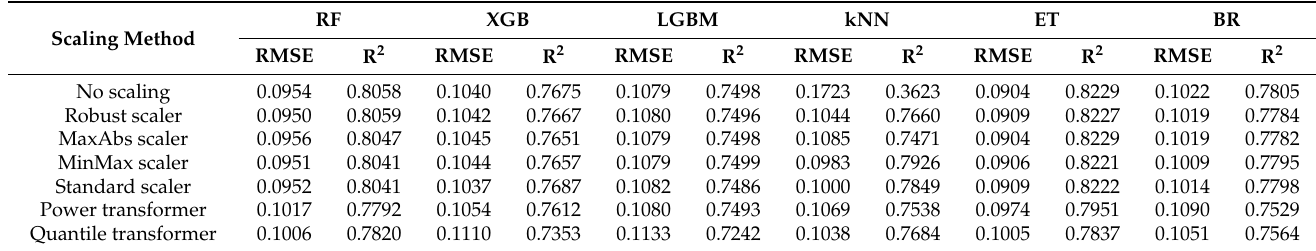
Table 8. The effect of different scalers on TRP prediction in The Cut.